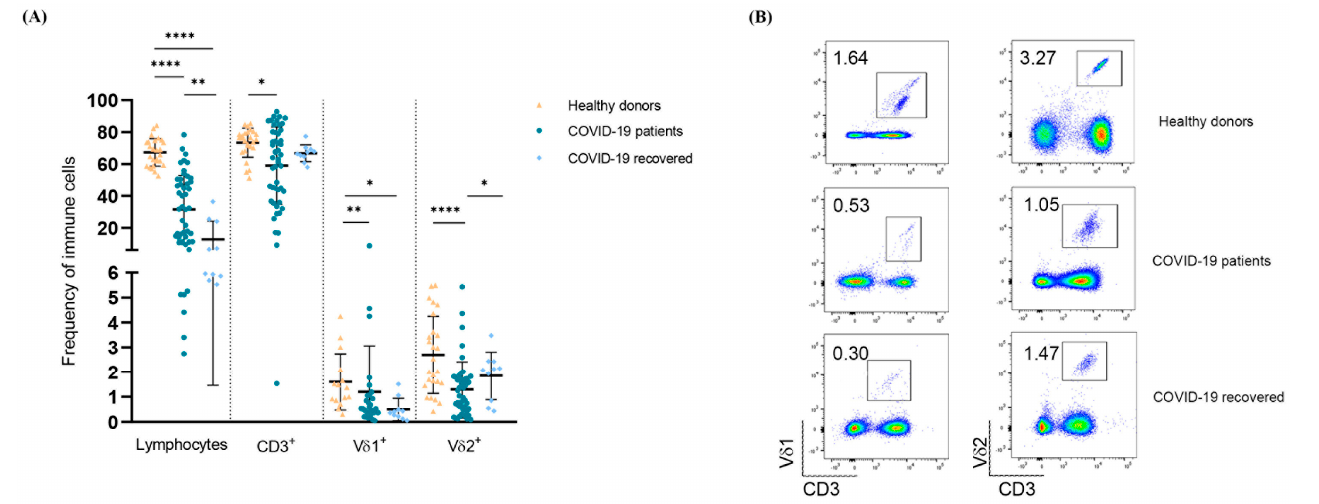
Figure 1. Frequency of V δ 1+ and V δ 2+ T lymphocytes in hospitalized and recovered COVID-19 patients and in healthy subjects. ( A ) Distribution of percentages of total lymphocytes, T (CD3+), V δ 1+ and V δ 2+ T lymphocytes in hospitalized and recovered COVID-19 patients, compared to healthy subjects. Shown is mean ± SD. ( B ) Representative dot-plots showing the frequency of V δ 1+ and V δ 2+ T lymphocytes in hospitalized and recovered COVID-19 patients and healthy subjects. * p < 0.05, ** p < 0.01, **** p < 0.0001.